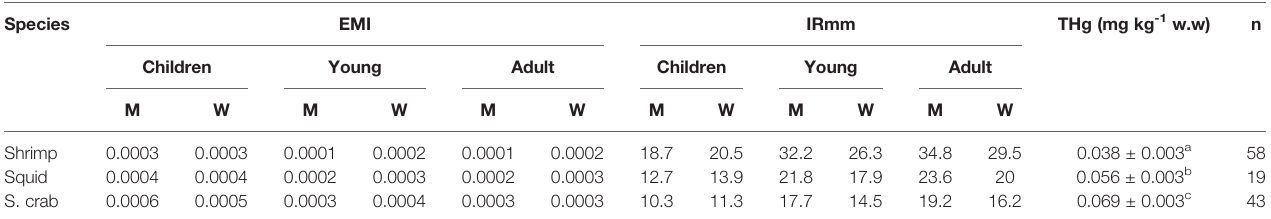
TABLE 2 | Maximum consumption rates for squid, shrimp, and swimming crabs sampled from Guanabara Bay, Rio de Janeiro, southeastern Brazil, per month (IRmm in kg month -1 ) and EMI (mg kg -1 month -1 ). Species